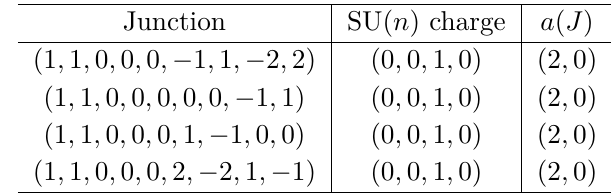
and v correspond to two vanishing cycles with endpoints x 1 2